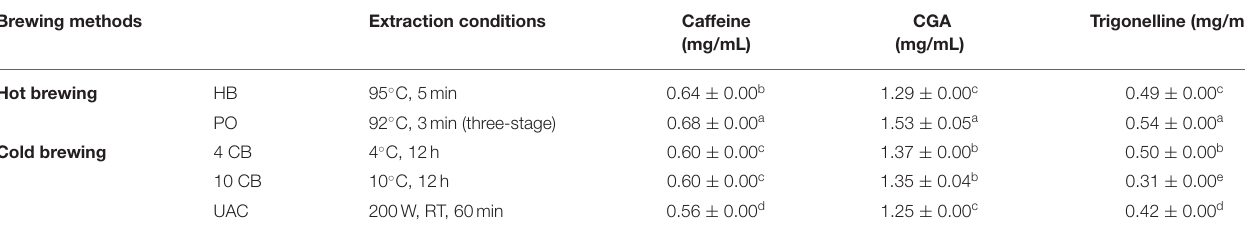
TABLE 2 | Contents of caffeine, CGA, and trigonelline in coffee with different brewing methods. Brewing